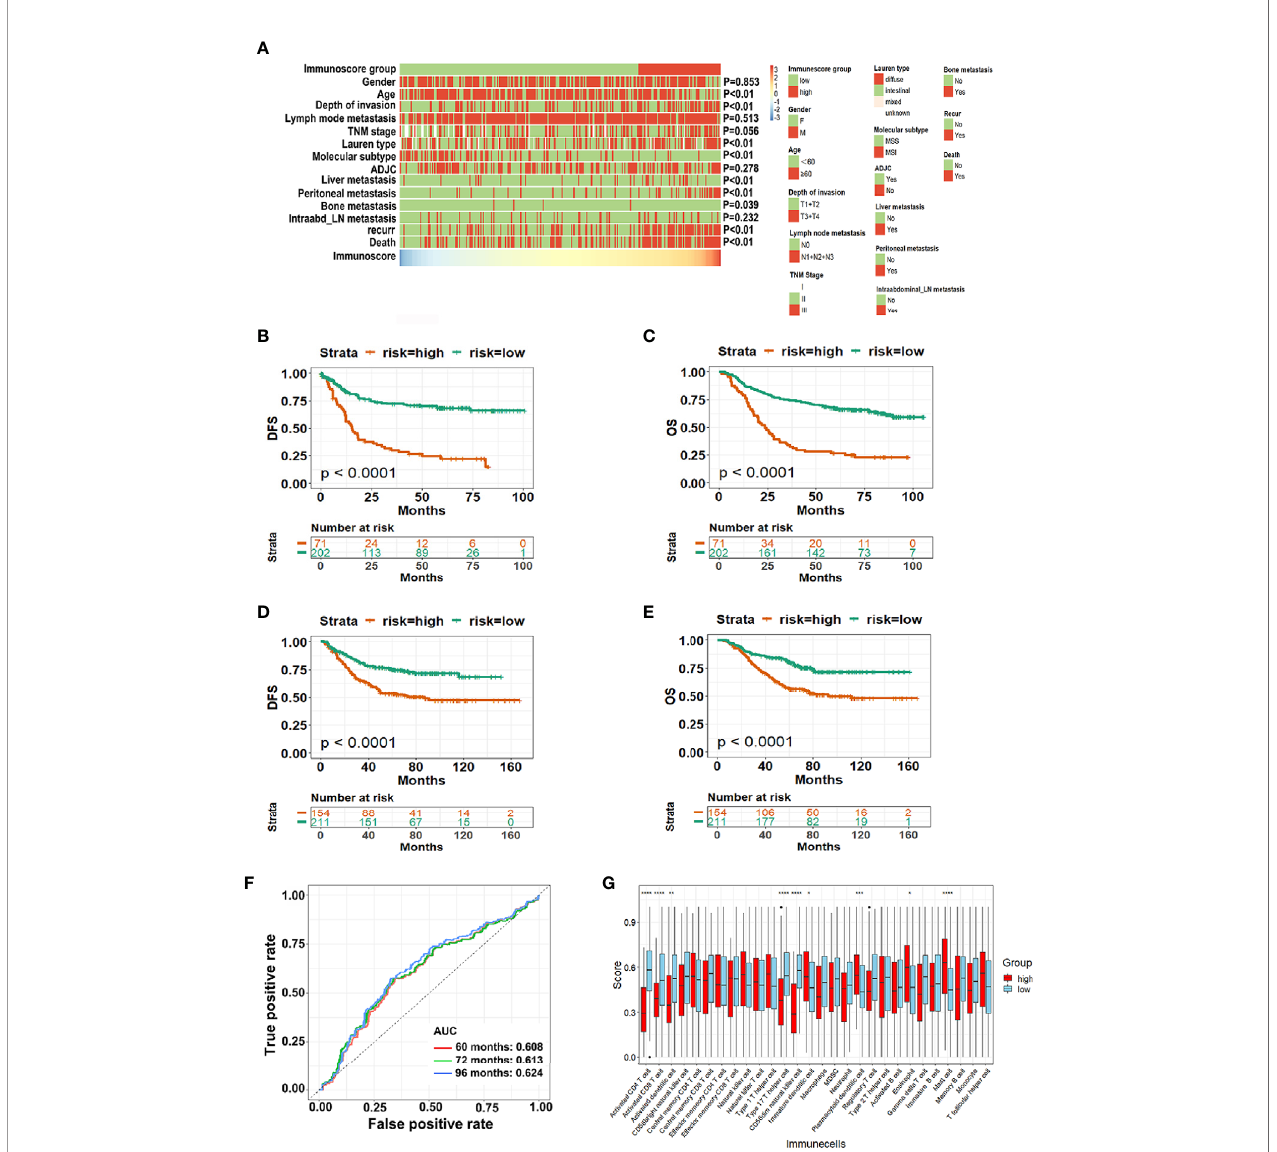
FIGURE 3 | The predictive value of IS for GC patients with surgery. (A) Heatmaps summarizing the distribution of IS and clinical pathological characteristics in the training cohort; (B, C) Kaplan-Meier analysis for the DFS and OS of GC patients in the GSE62254 dataset; (D, E) Kaplan-Meier analysis for the DFS and OS of GC patients in the GSE26253 dataset; (F) The IS measured by time-dependent ROC curves in the testing cohort. The area under the ROC curve was de fi ned as AUC; (G) Distribution of 28 immune cells transformed using ssGSEA in high-IS and low-IS groups. ADJC , adjuvant chemotherapy; Intraabd_LN intraabdominal lymph nodes; DFS , disease free survival; OS , overall survival; GC , gastric cancer; ssGSEA single-sample gene set enrichment analysis; IS , immunoscore; ROC , receiver- operating characteristic. * P < 0.05; ** P < 0.01; *** P < 0.001; **** P <